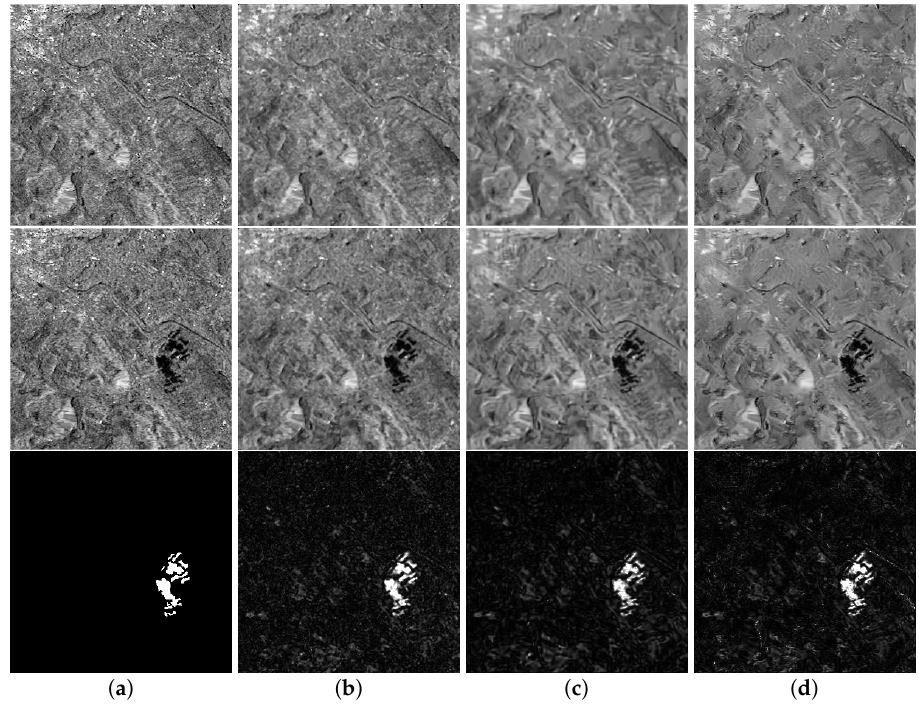
Figure 1. Bern dataset. ( a ) Raw images from April 1999 and May 1999 and the reference map. ( b – d ) Filter images by MMSE, SAR-block-matching and 3D filtering (BM3D), probabilistic patch-based (PPB), and the corresponding